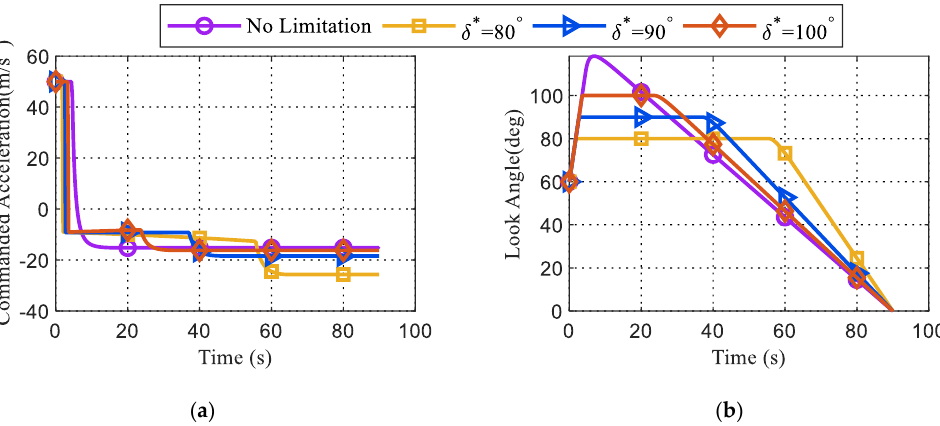
Figure 8. The results with different constraints on look angle. ( a ) Trajectories; ( b ) Distance-to-go. Figure 9. The results with different constraints on look angle. ( a ) Lateral accelerations; ( b ) Look angles.